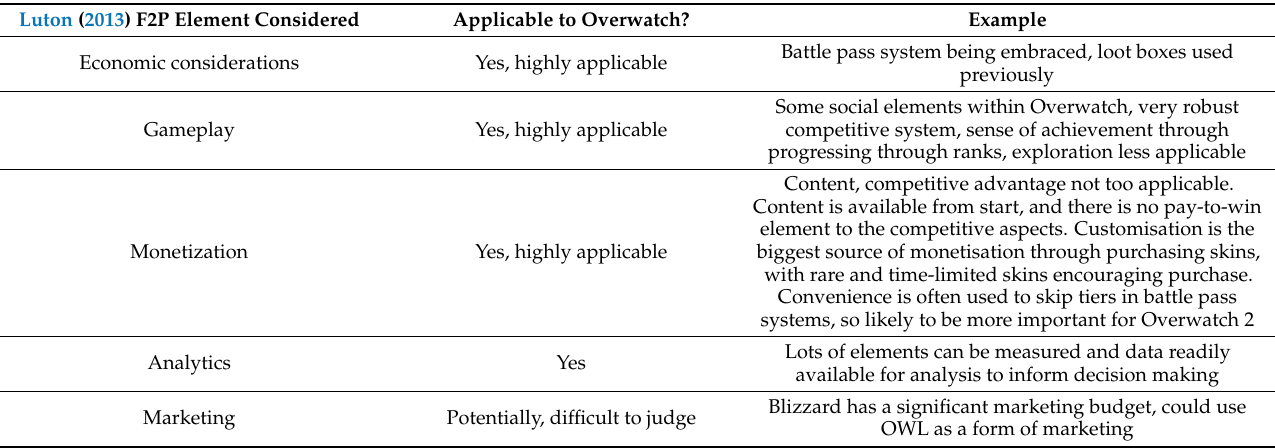
Table 2. Application of Luton (2013) to